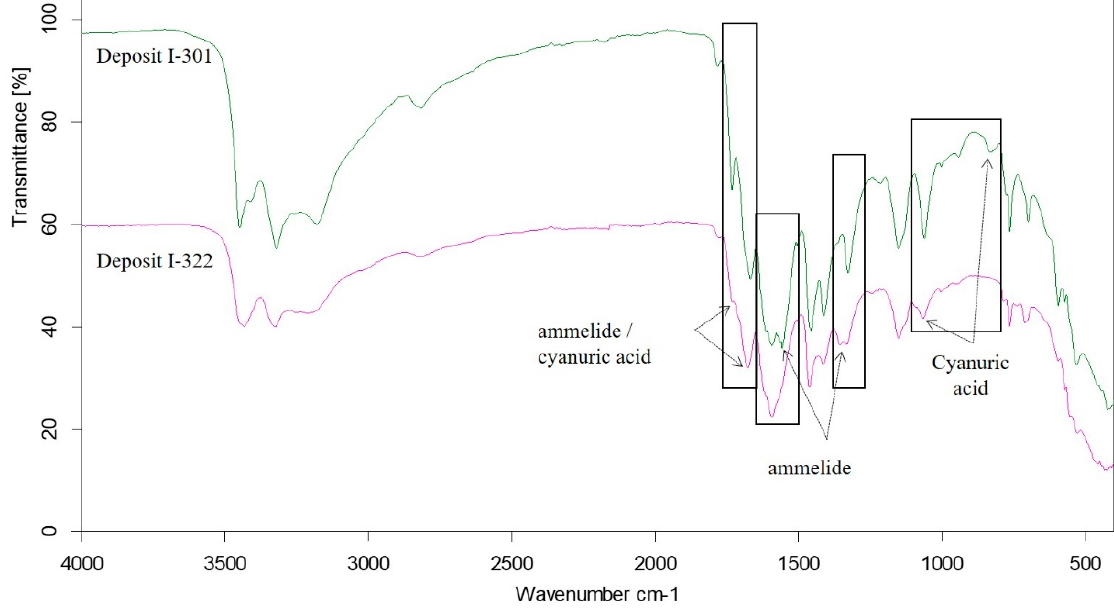
Figure 8. FTIR spectra of deposits I-301 and I-322 obtained at T air = 375 °C (T sample = 301 °C) and T air = 400 °C (T sample = 322